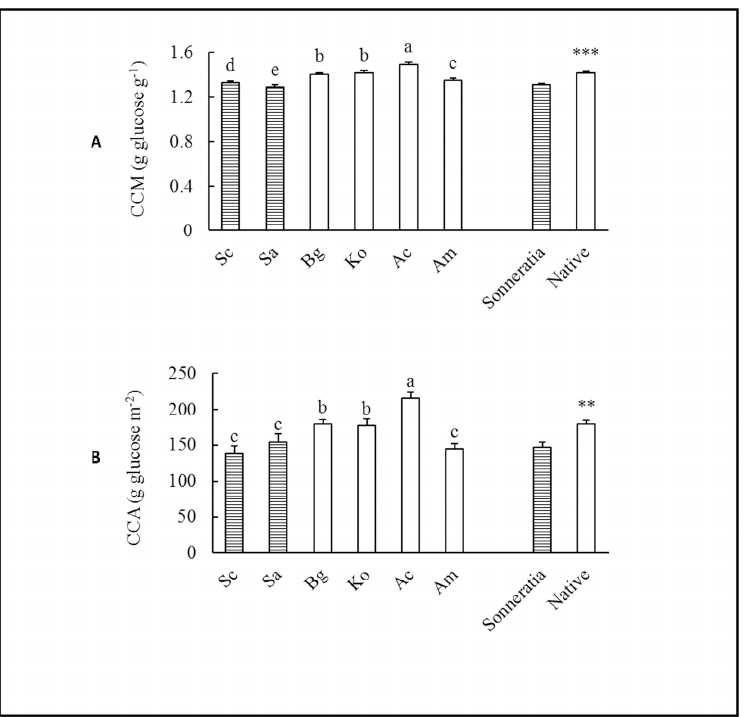
Fig 3. Comparisons of the annual average (A) leaf CCM and (B) CCA between alien Sonneratia and native mangrove species. Fig 3 legend: Error bars represent 1 SE. Different letters indicate significant differences at p (cid:6) 0.05 among the six species according to two-way ANOVA; ** and *** indicate significant differences between alien Sonneratia and native mangrove species at p (cid:6) 0.01 and p (cid:6) 0.001 according to the independent samples T-tests,